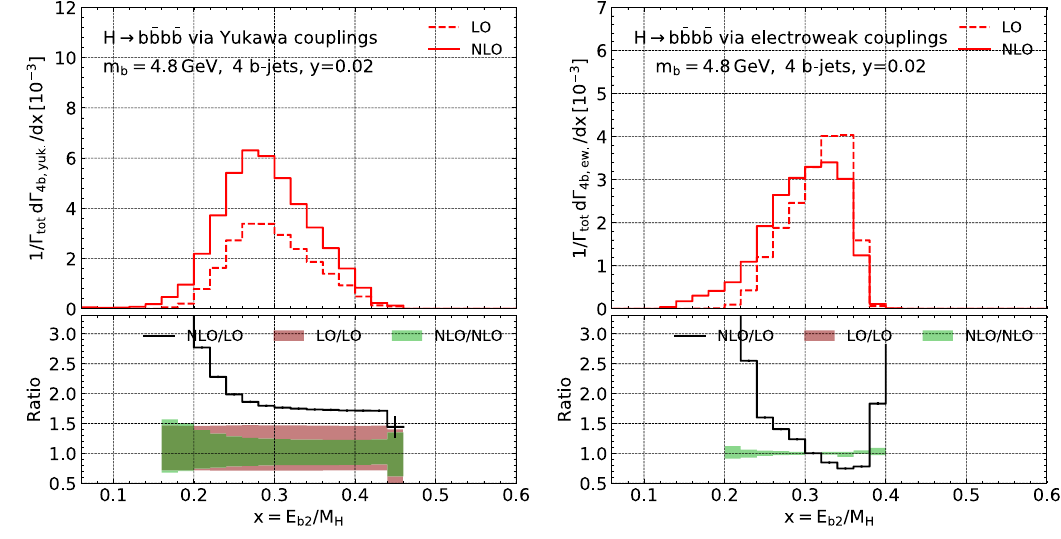
Figure 8 . Similar to figure 7 for distribution as a function of the energy of the sub-leading b -jet. decay channels show clearly differences. For instance, the (sub-)leading jet peaks at slightly lower(higher) values for decay via electroweak couplings. The energy spectrum of the third and fourth jets are broader for decay via Yukawa couplings. Beside of the normalization, the QCD corrections induce changes on shape of the distributions. The spectrum is generally pushed to lower energy region due to the recoiled gluon in QCD real corrections, except for energy of the third and fourth jets in decay via electroweak couplings, where enhancements are found right after the peak